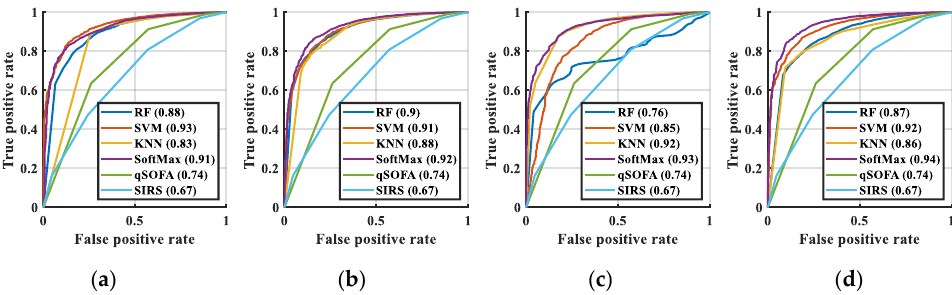
Figure 6. Area under curve (AUC) curve of the mortality prediction for the testing dataset at 72 h: ( a ) no feature extraction, ( b ) PCA, ( c ) AE, ( d ) CNN. Abbreviation: SIRS, systemic inflammatory response syndrome; qSOFA, quick sepsis-related organ failure assessment; RF, random forest; KNN, K nearest neighbor; SVM, support vector machine; PCA, principal component analysis; AE, autoencoder; CNN, convolutional neural network.